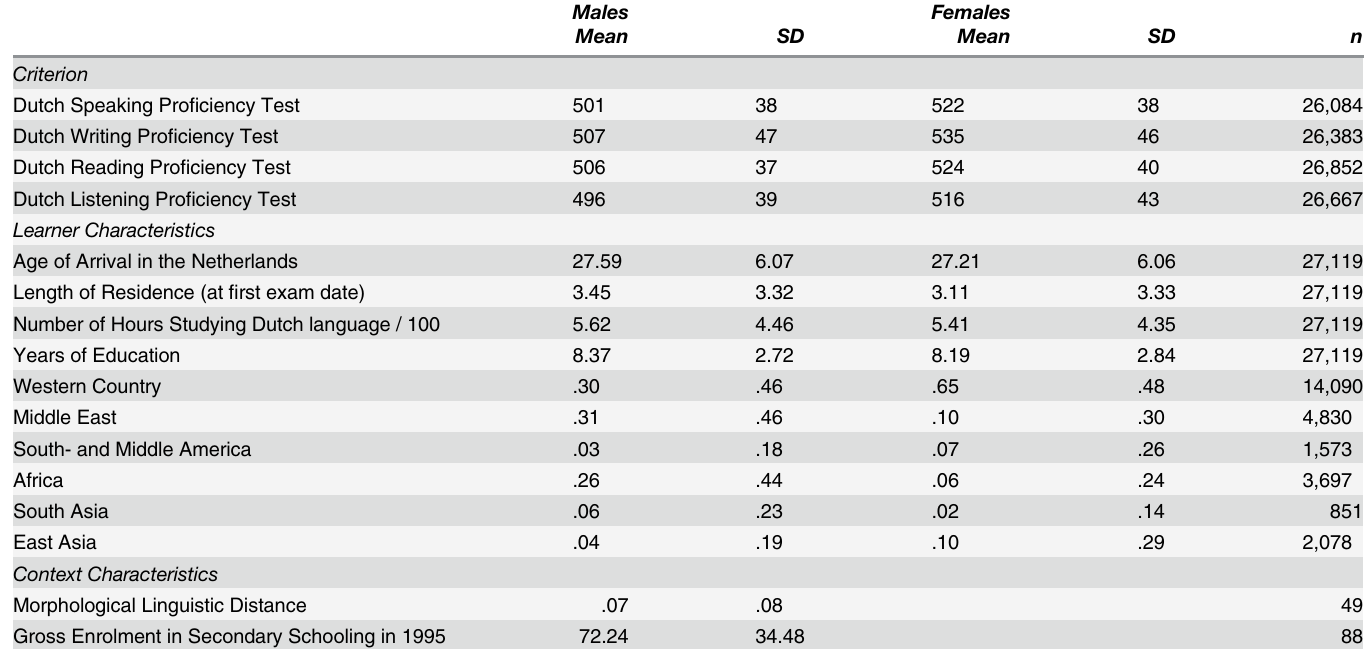
Table 1. Description of the Sample for the Dependent Variable, the Dutch Speaking, Writing, Reading, and Listening Proficiency Test, and the Explanatory Variables, Split out between Learner and Context Characteristics (49 L1s and 88 Countries), for Male and Fmale